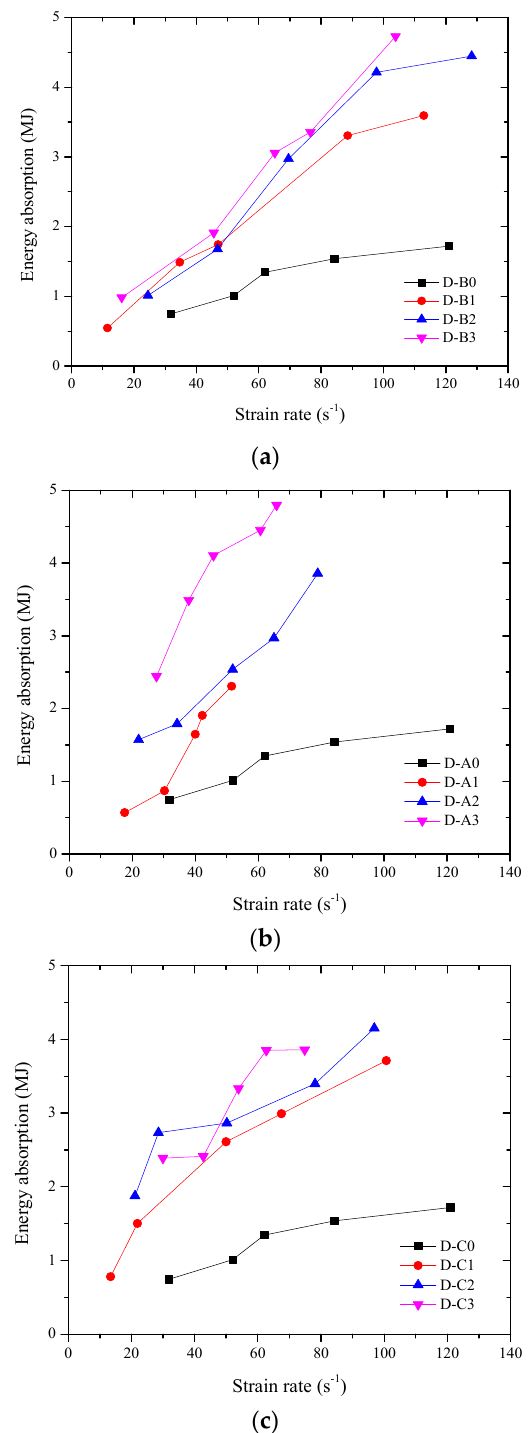
Figure 12. Relationship between the energy absorption and the strain rate. ( a ) BFRP-confined specimens; ( b ) AFRP-confined specimens; and ( c ) CFRP-confined specimens.